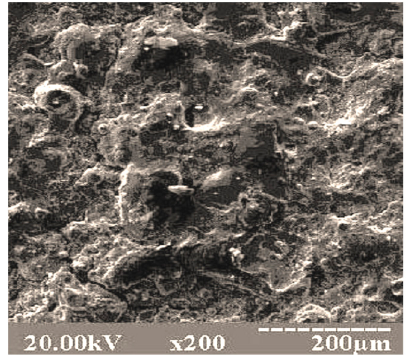
Figure 4. The surface of the sample coated with V 2 O 5 /C.